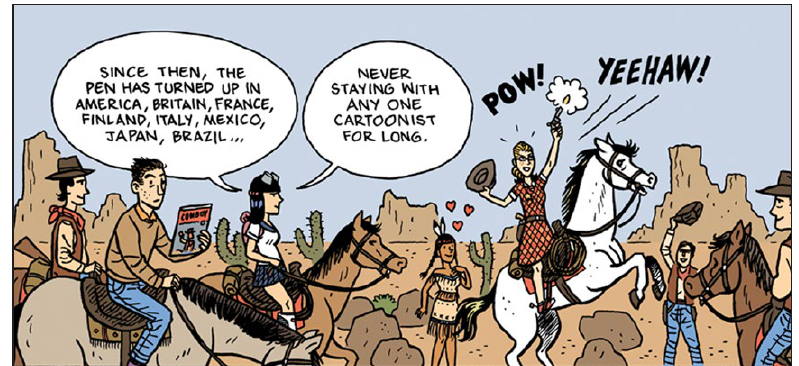
Figure 6: h eart for affection ( Sam Zabel and the Magic Pen : 147) © Dylan